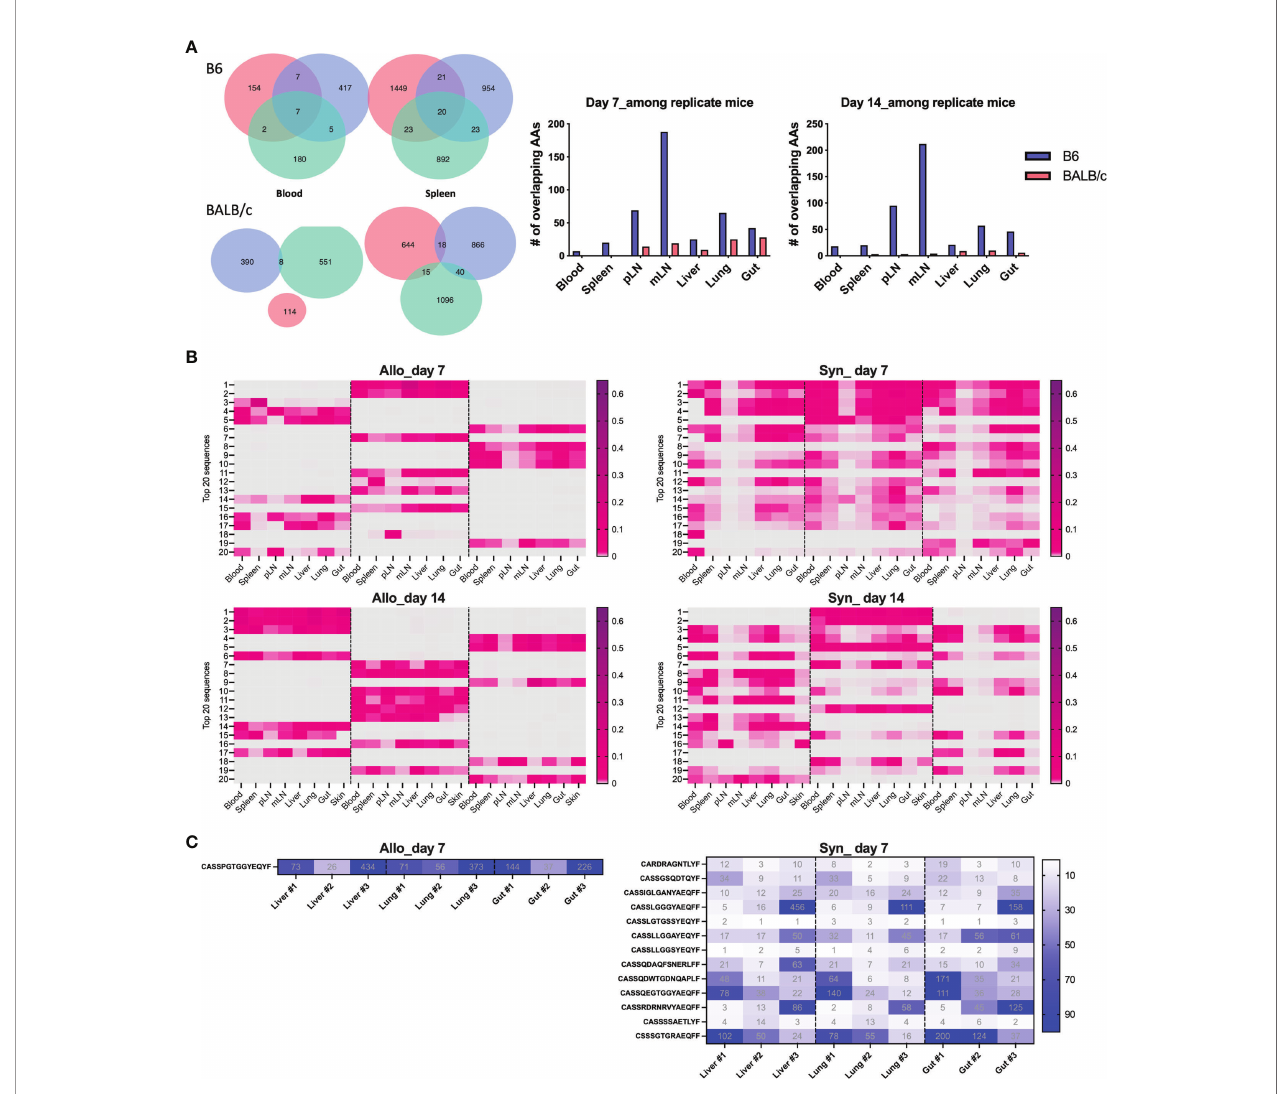
FIGURE 6 | De fi ne mouse-speci fi c top T-cell clones after allogeneic BMT. Venn diagram shows the number of overlapped CDR3 AAs among replicate recipients on day 7 post BMT (A) . Top 20 sequences ranking by combined frequency in all tissues in a designated recipient group. The frequency of these clones in designated tissues from individual recipients are shown in the heatmap (B) . The shared clones within top 500 CDR3 AAs and among replicate recipients were listed and the clone rank of these clones are shown in liver, lung, and gut on day 7 after BMT (C)